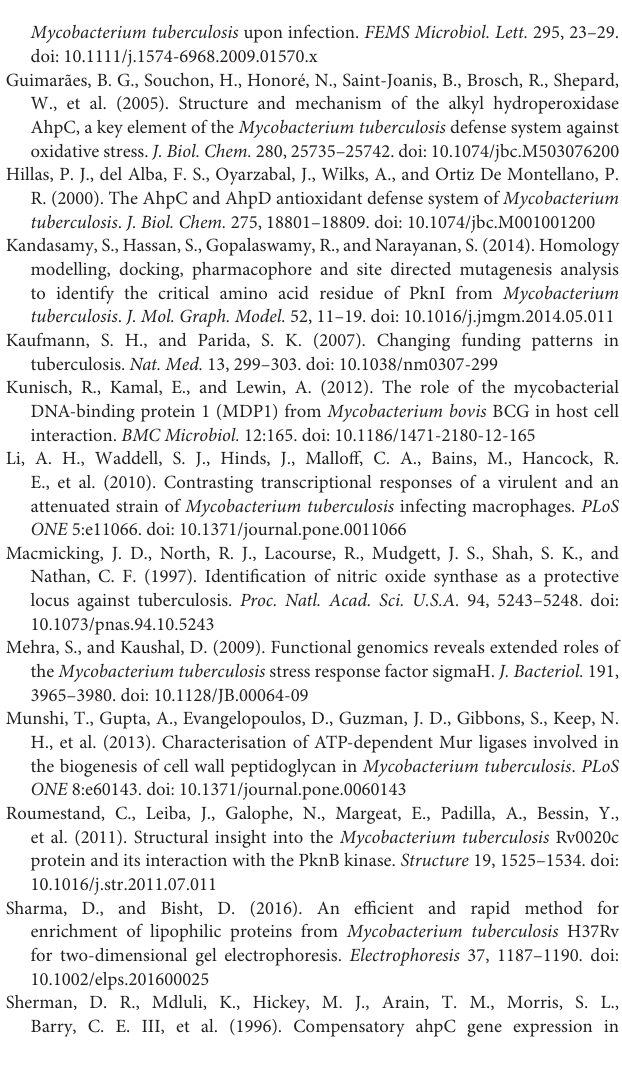
Figure S1 | DTT oxidation assay for Rv2159c. Quantification of cysteine oxidation with Rv2159c WT and its catalytic site mutants (C81S, C84S, C81/84S) in the presence of DTT. Table S1 | List of constructs used in this study. Table S2 | Details of primers used in this